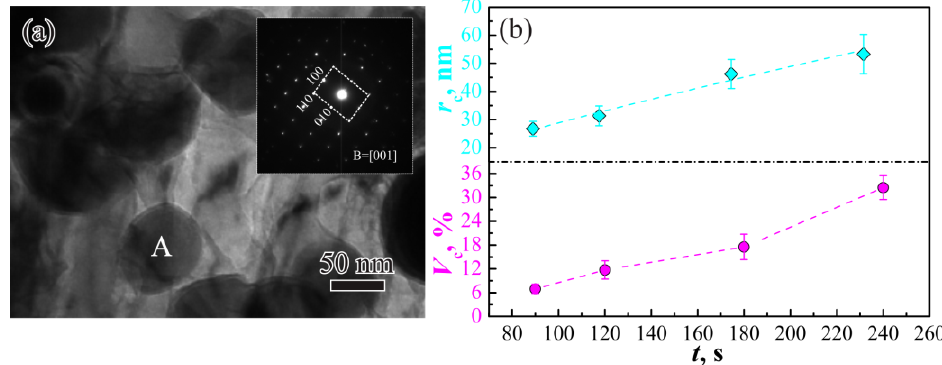
Figure 4. ( a ) TEM image and selected area electron diffraction of the carbide (Site A); ( b ) variations of r c and V c with t .